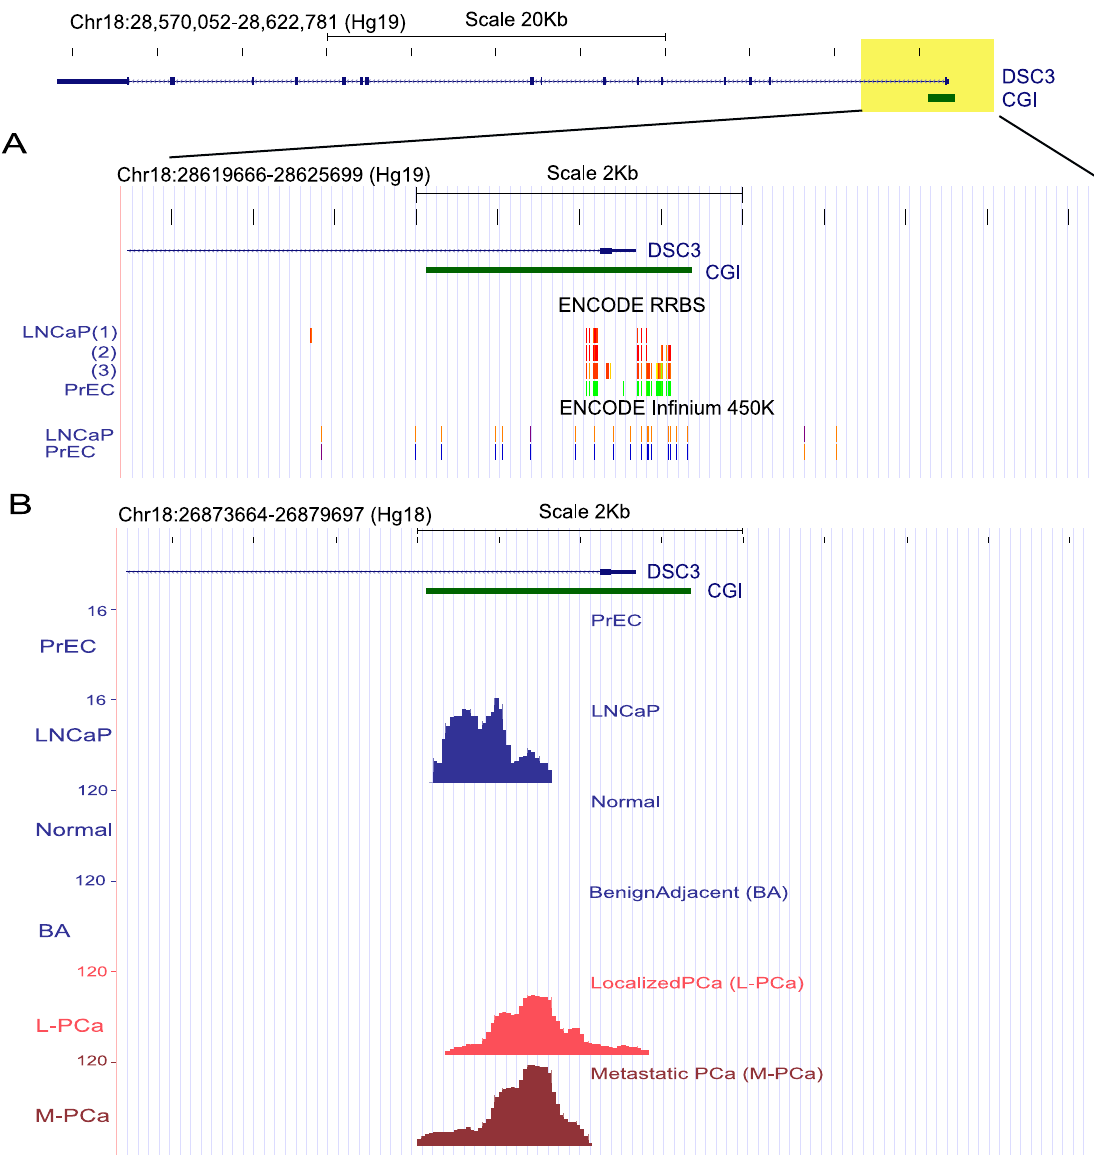
Figure 2. DSC3 Promoter is Hypermethylated in Prostate Cancer. (A) Top panel depicts the UCSC genome browser representation of the genomic organization of DSC3 gene present in human chromosome 18 (28570052-28622781), where exons are indicated by solid boxes and introns by the blue line. The CpG island (CGI) associated with the DSC3 gene promoter is represented as horizontal green solid bar. DNA methylation status of the regions shaded in yellow ( + / 2 3 kb from transcription start site) is presented below. ENCODE Infinium 450K Bead Arrays and Reduced Representation Bisulfite Sequencing datasets (RRBS) showed that DSC3 gene promoter is hypermethylated in LNCaP as compared to the benign cell line PrEC. The CG positions assayed by these methods are represented as vertical bars colored according to their methylation status. ENCODE RRBS, red (100%), yellow (50%), green (0%) are methylated; ENCODE Infinium 450K, orange = methylated (score $ 600), bright blue = unmethylated (0 , score # 200). LNCaP(1):LNCaP cells treated with androgen; LNCaP(2):LNCaP data from Duke University; LNCaP(3):LNCaP data from University of Washington. (B) Representation of MethylPlex NGS sequencing data (PrEC, LNCaP, prostate normal, benign adjacent, localized PCa and metastatic PCa tissues) for DSC3. Methylated regions observed in the corresponding sample groups are depicted as peaks and numbers in the y-axis denote the peak heights.